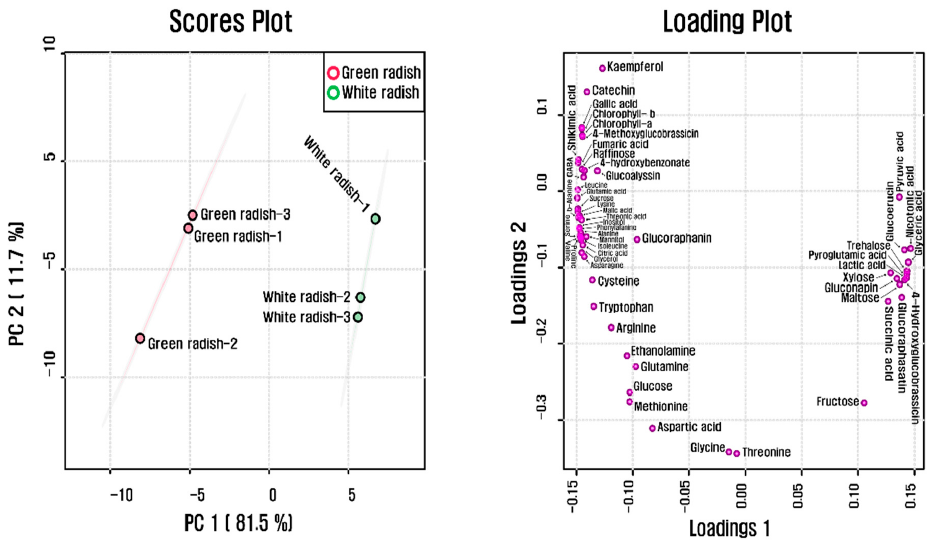
Figure 2. Scores and loading plots of PCA model for metabolites present in green and white radish roots.